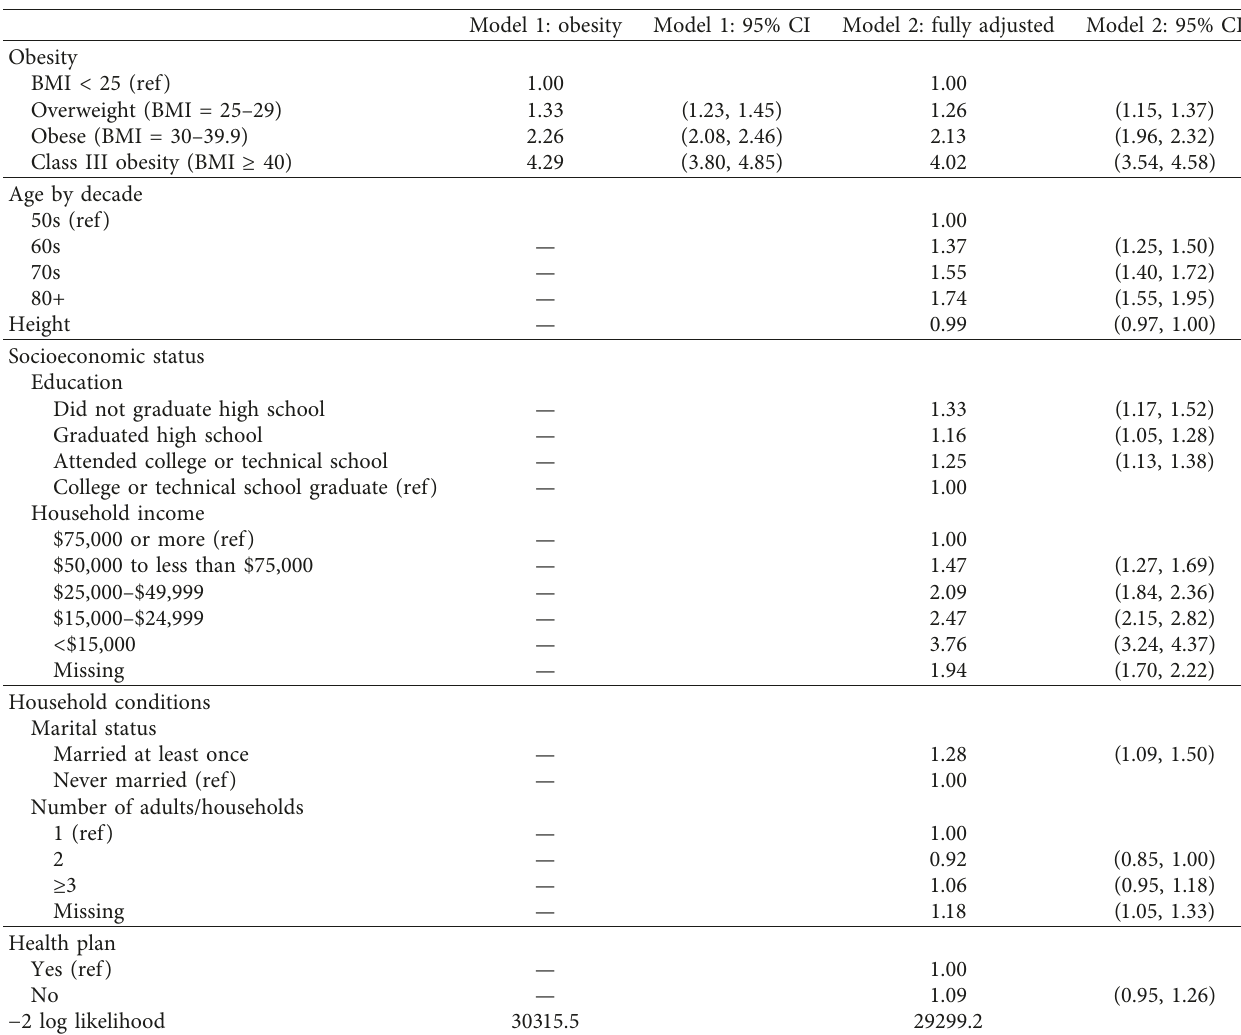
Table 2: Logistic regression analyses of COPD among non-Hispanic white older women (aged 50+) who had never smoked ( n � 76 , 004) (odds ratios and 95% confidence intervals